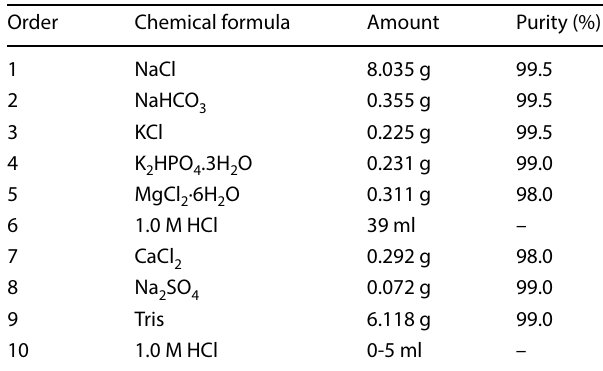
Table 1 Chemical reagents and purities used in preparing SBF media [34] Order Chemical